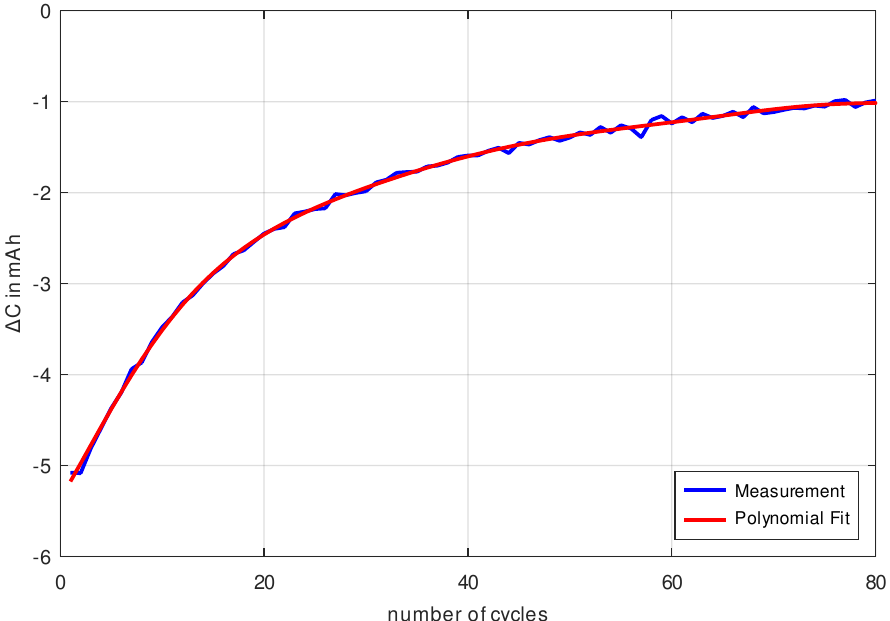
Figure 6. Difference between single capacity measurements observed over the measurement cycles. For this purpose, an LG INR18650 MJ1 cell was cycled with C/4 at 40 °C ambient temperature. An 8th order polynomial was approximated to the measured data to calculate the noise component, which is shown in Figure 7.